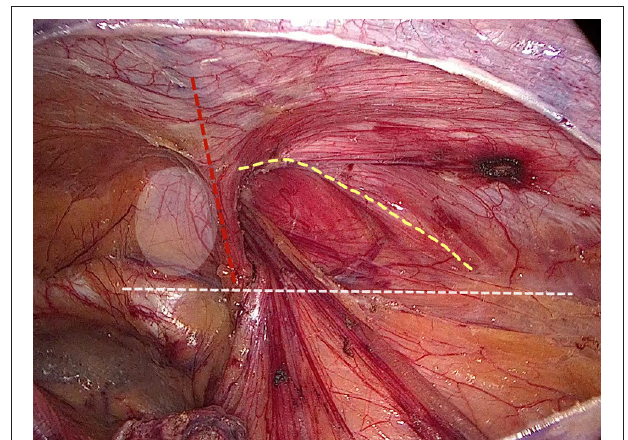
FIGURE 1 | Surgical field after space dissection and sac management. (Red dashed line: epigastric vessels; hatched area: transversalis fascia; white dashed line: ilio-pubic tract; yellow dashed line: conjoined tendon).